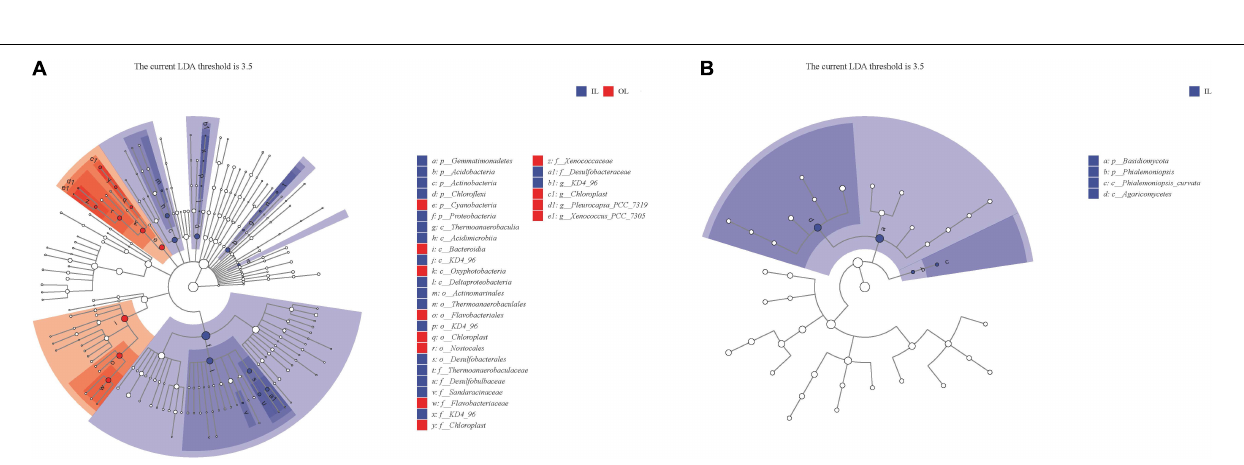
FIGURE 4 | Clade diagram of the LDA scores computed for differentially abundant bacterial (A) and fungal (B) genera in the sediments between Qilianyu lagoon and the surrounding area.